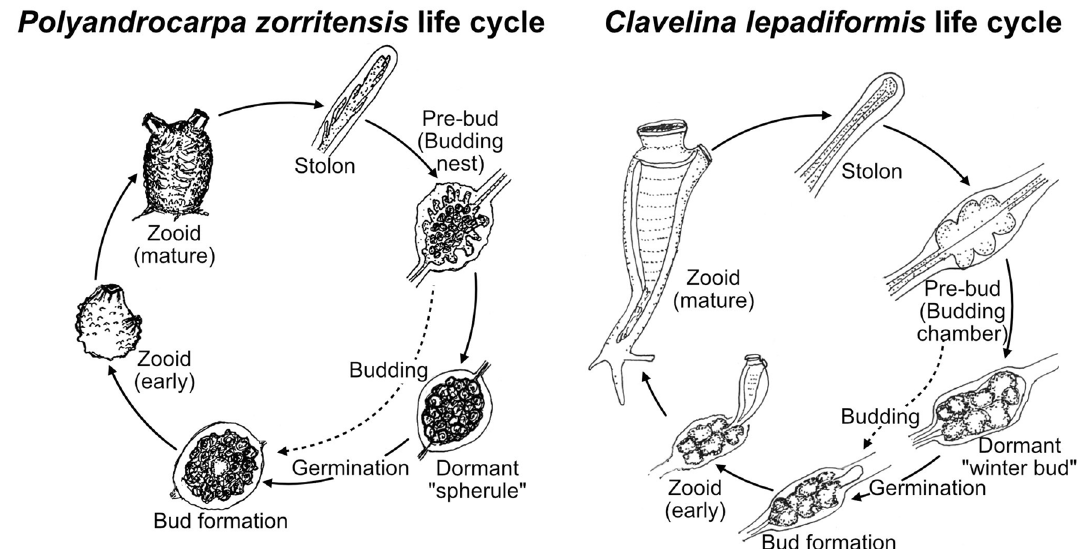
Figure 2. Asexual life cycles of Polyandrocarpa zorritensis and Clavelina lepadiformis. At the base of mature zooids of both P. zorritensis and C. lepadiformis , extensions of the blood vessels encased in tunic, called stolons, protrude along the substrate. Along the stolons, ramifications of the internal blood vessels develop that we call “pre-buds” here (and are also known as “budding nests” in P. zorritensis and “budding chambers” in C. lepadiformis ). The pre-buds swell and the surrounding tunic thickens to form structures called “spherules” for P. zorritensis or may accumulate opaque mass inside the vessel to become what has been called “winter buds” in C. lepadiformis . These dormant forms go on to germinate into a new zooid, but they have the capacity to withstand harsh conditions before germinating. Note that the pre-bud can also initiate the budding process without passing through a dormant state, as indicated by the dotted line in each life